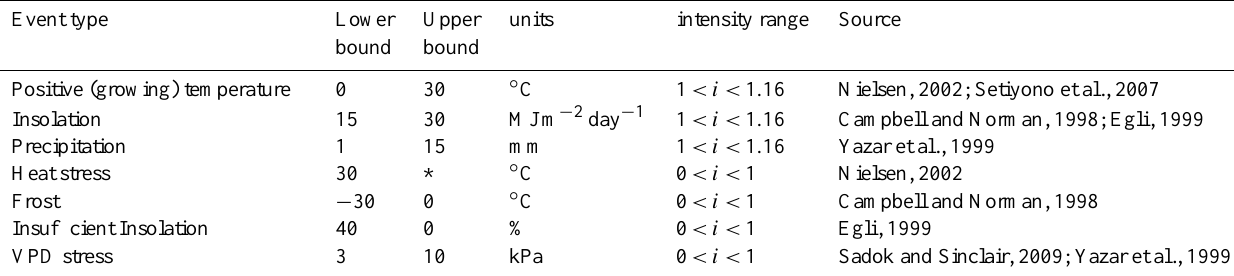
Table 2. Thresholds and bounds used for deriving